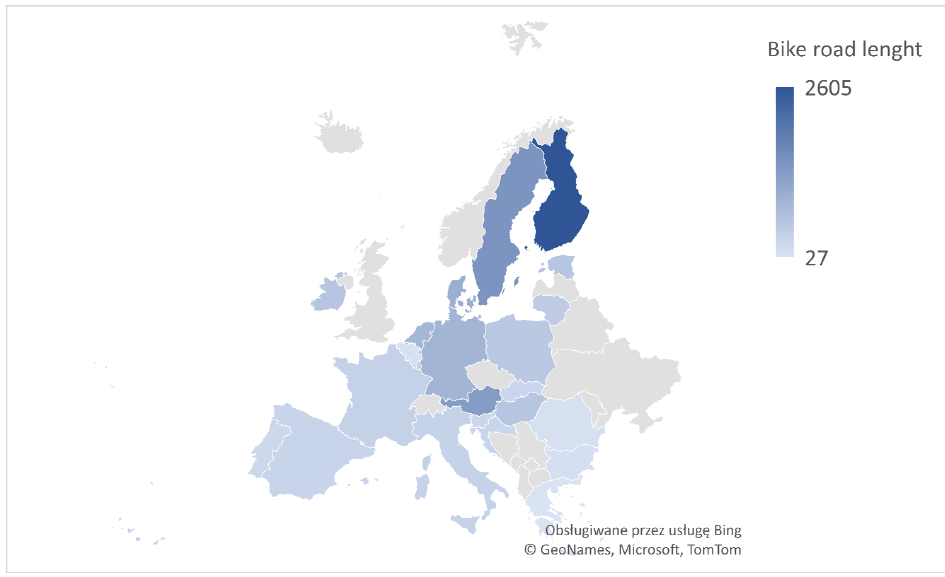
Figure 2. Bike road length in smart cities in European Union countries. Source: author’s analysis.